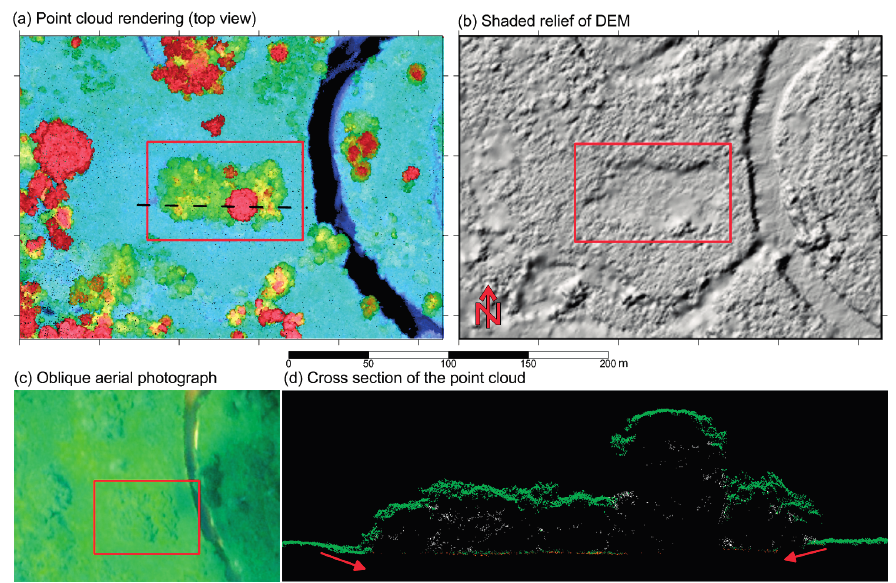
Figure 14. Potential data artifact (false positive) created by the limitations of discrete ALS systems with dense short vegetation surrounding thick tree canopies. ( a ) Top view rendering of the PC; ( b ) shaded relief image of the DEM showing an apparent rectangular depresion; ( c ) oblique aerial photo of the area; ( d ) cross section of the